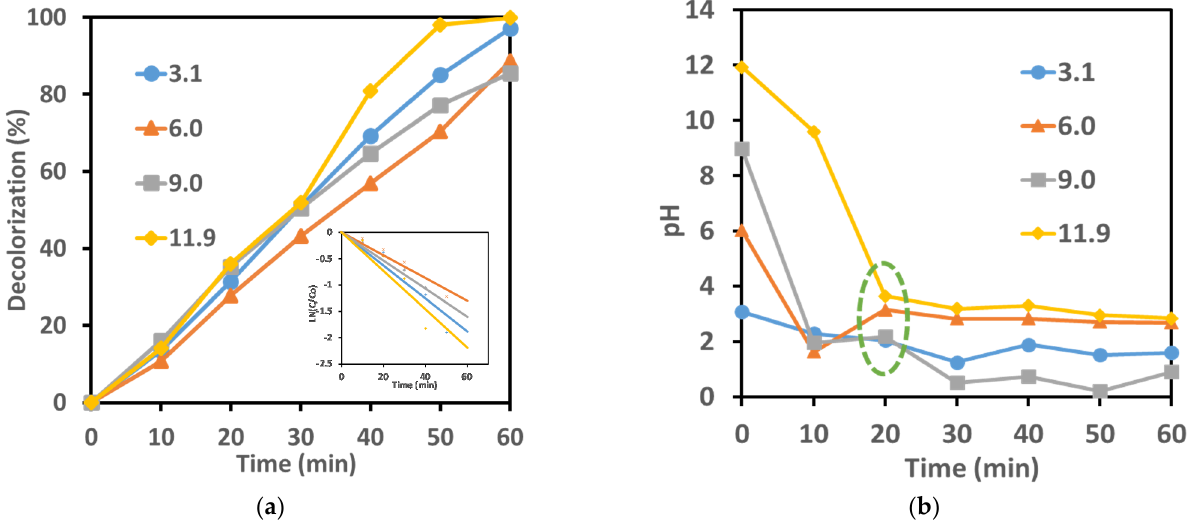
Figure 8. ( a ) Effects of pH on decolorization efficiency. Na 2 SO 4 electrolyte: 0.05 mol L −1 ; reaction time: 1 h; electrode distance: 3 cm; initial pH: 3.1–11.9; reaction temperature: 25 °C; MB: 9 mg L −1 ; cell voltage: 20 V. ( b ) pH change vs. treatment times.